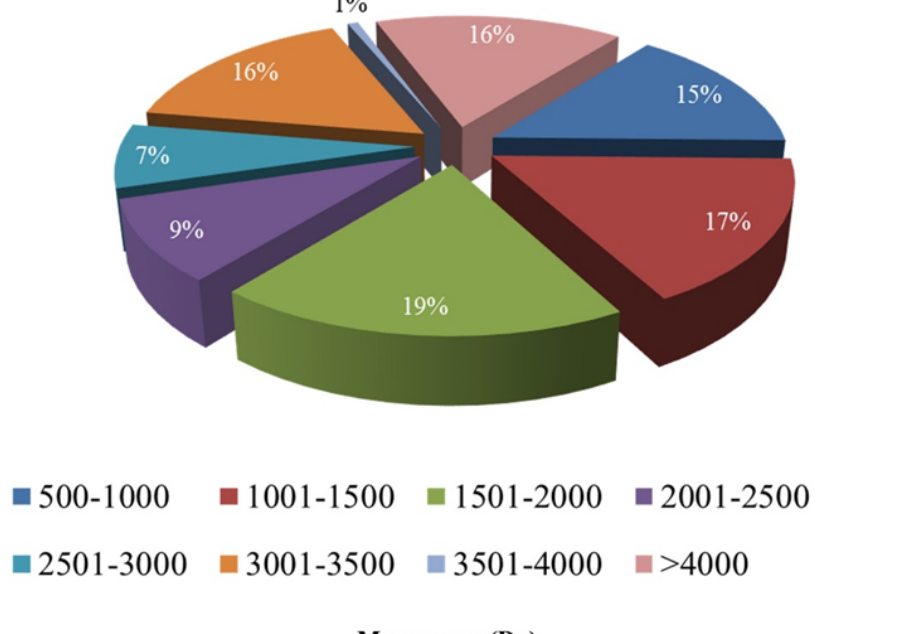
Figure 3. Molecular mass distribution of the components in C. taeniatus venom detected by